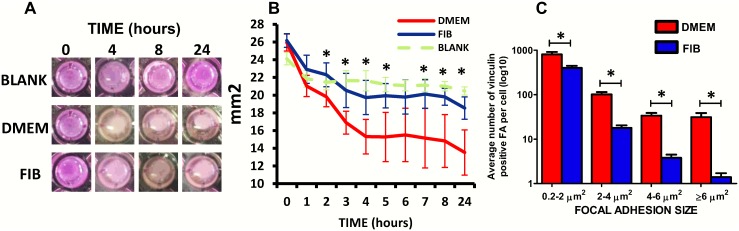

Collagen gels showing differing degrees of contraction in DMEM and FIB media (A). Graph showing the temporal pattern of gel contraction by VICs in the 2 media (B) and graph showing the average number of different sized focal adhesions in the two media (C). Data labelled as FIB is from VICs that were switched to fibroblast media for 2 weeks prior to analysis.